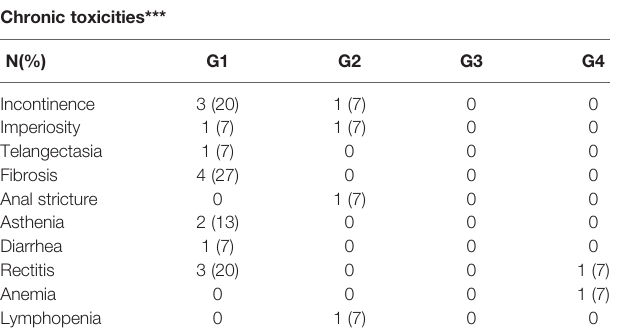
TABLE 4B | Toxicities related to chemoradiation.